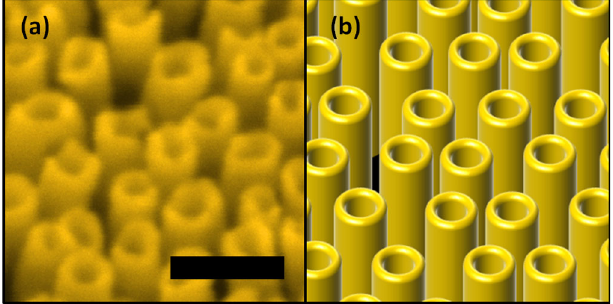
FIG. 5. (a) SEM image taken at 40 (cid:2) from normal of Au nanotubes (scale bar ¼ 100 nm ) and (b) matching schematic